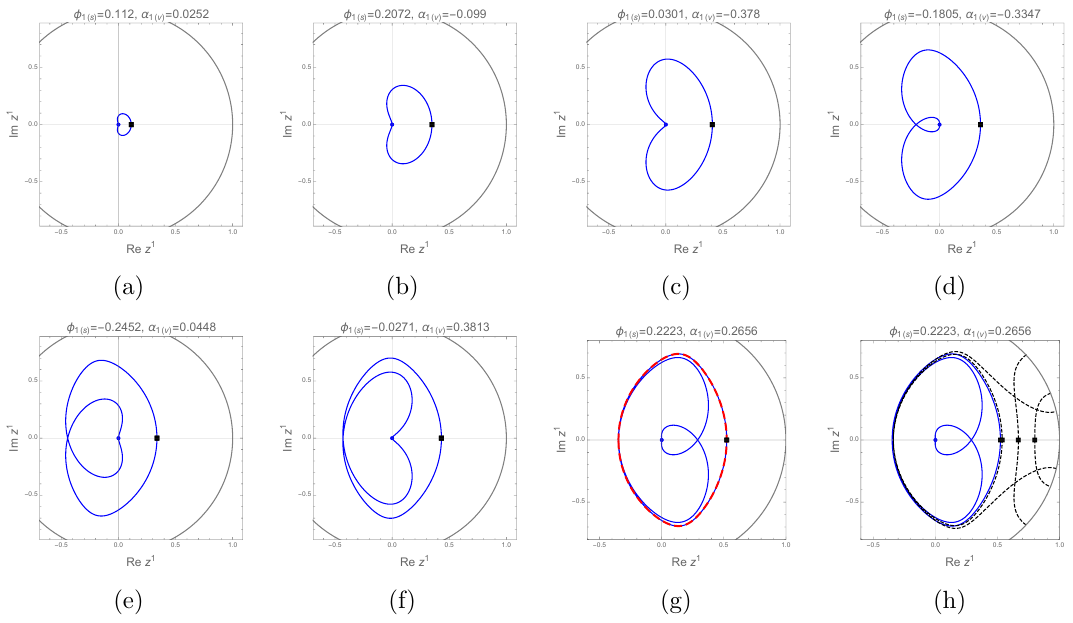
Figure 3. A family of symmetric BPS solutions for the N = 1 ∗ equal mass model is summarised by parametrically plotting the real and imaginary parts of the scalar field z 1 ; the behaviour of the other scalar field z 2 is broadly similar. The black squares correspond to turning points of the function A J ( r ) , where the phase of both scalars is zero. The family of solutions can be labelled by ( α 1 ) tp , a function of z 1 and z 2 at the turning point invariant under shifts of the dilaton. The blue dot at the origin is the N = 4 SYM AdS 5 vacuum and the blue lines are Janus solutions. As ( α 1 ) tp increases monotonically from (a)–(g), we see the appearance of more and more loops, asymptoting to the red curve, in figure (g), which describes a solution periodic in the radial direction. In figure (h) we have exactly the same solutions as figure (g) but with the addition of some illustrative solutions (black dashed lines) that are singular at both ends (and without the red curve for clarity) . As one moves from r = −∞ to r = + ∞ one moves clockwise on the